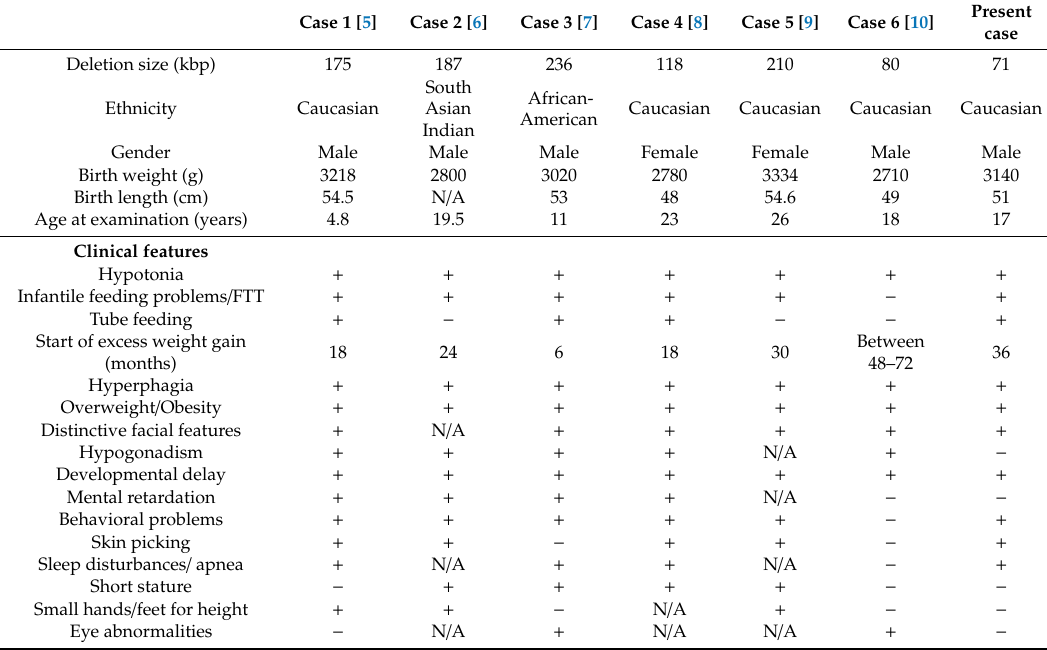
Table 1. Comparison of present case with previously published cases with SNORD116 microdeletion.